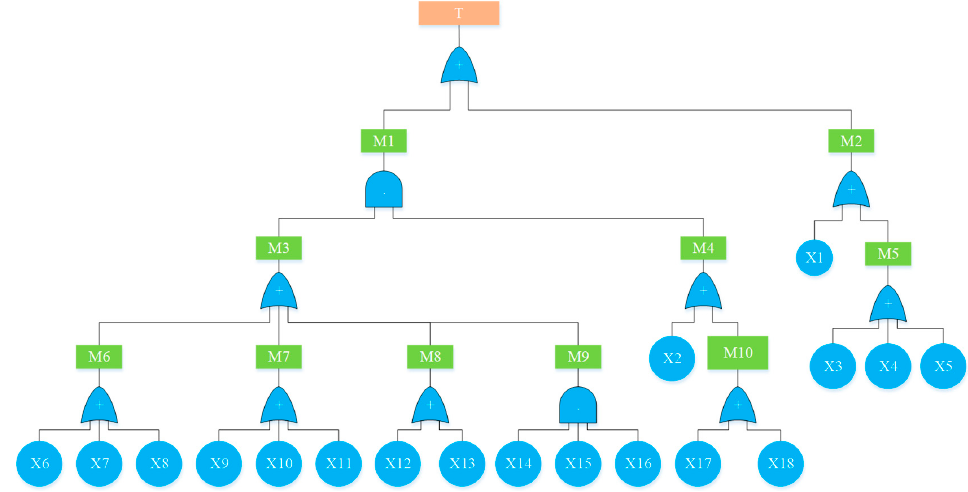
Figure 5. Fault tree of liquid ammonia leakage.